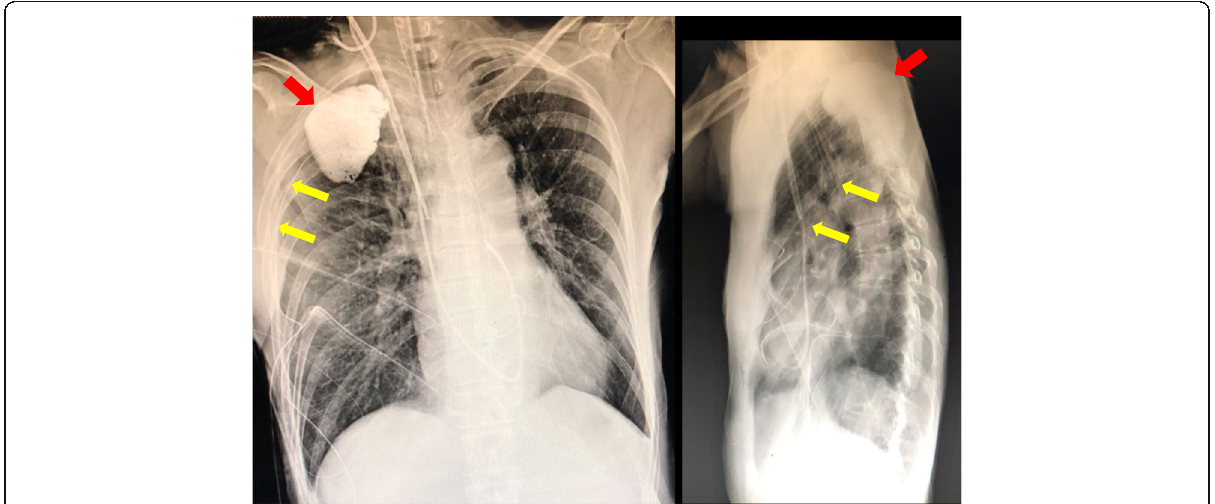
Fig. 2 Frontal and lateral chest radiograph images showing the spread of contrast medium. The contrast medium was localized across the 3rd to the 5th intercostal area in the posterior chest. Yellow arrows indicate the inserted catheter, and red arrows indicate the administered contrast